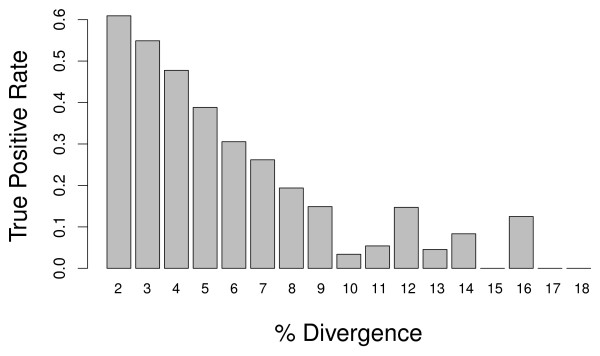
Success of X detection in D. simulans, as influenced by sequence divergence. Proportion of X features identified as having greater genomic content in D. simulans female at each level of sequence divergence from D. melanogaster. Features of low sequence divergence (0-1%) are not shown.